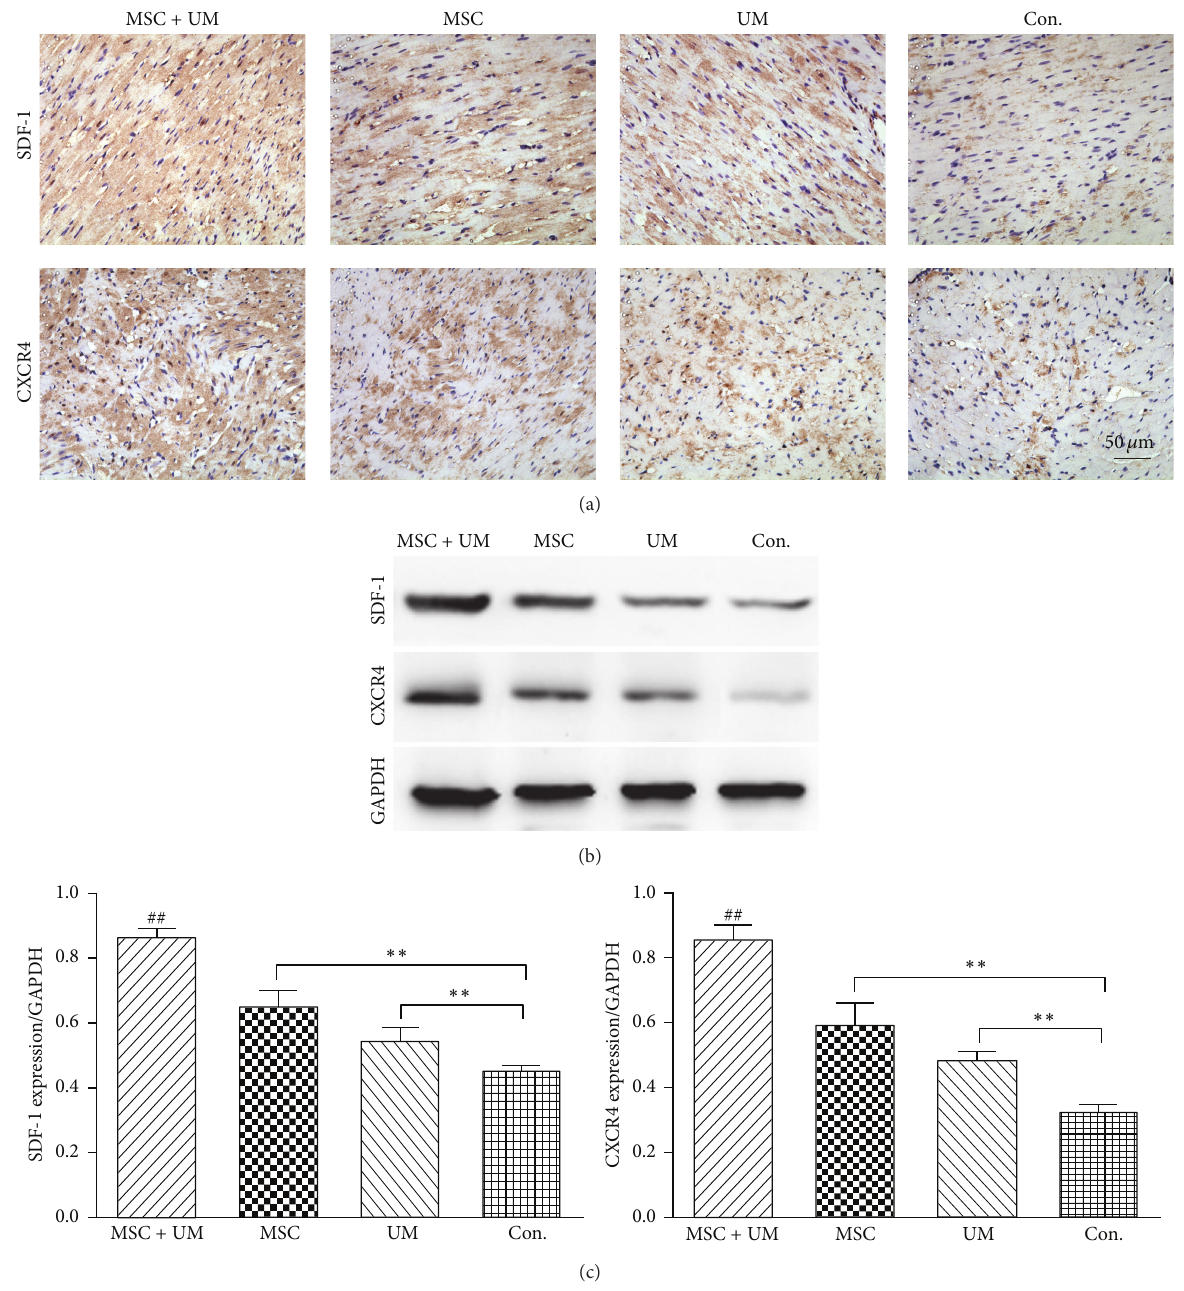
Figure 7: Expression of SDF-1 and CXCR4 by IHC and Western blot. (a) The immunohistochemistry results showed that the number of SDF- 1- and CXCR4-positive cells was highest in the MSC + UM group. There were relatively fewer positive cells in the MSC group and UM group, and the control group had the lowest number of SDF-1- and CXCR4-positive cells. (b) Protein expression of SDF-1 and CXCR4 determined by Western blot in ischemic myocardium from four groups, with GAPDH as the internal control. (c) Quantification of SDF-1 and CXCR4 expression was performed by densitometric scanning. The scale bar represents 50 𝜇 m. All values are expressed as the mean ± SD. ∗∗ 𝑃 < 0.01 ; ## 𝑃 < 0.01 versus other groups; 𝑛 = 6